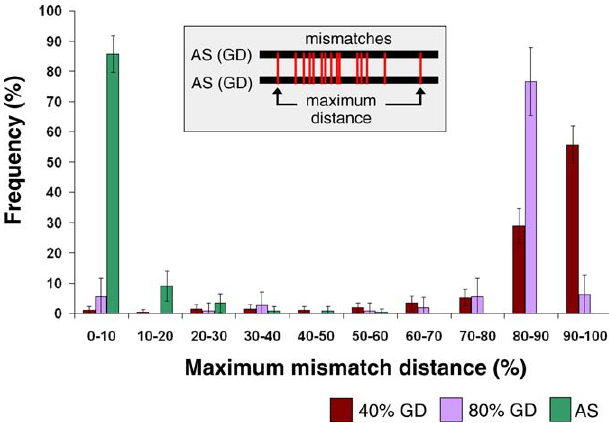
Figure 4. The Distribution of Nonconservative Changes along Sequences The maximal mismatch distance between nonconservative substitutions is much smaller in AS than in GD. The maximal mismatch distance is the number of residues between the two most distant, nonconservative substitutions, normalized by sequence length. Nonconservative mis- matches have a negative value in the Blosum62 matrix [65] and were chosen for their stronger impact on protein structure and function. The plot depicts AS data in green, and GD data for families at 80% and 40% seq.id. in light violet and dark red, respectively. We observe that nonconservative substitutions in AS are much more localized than those in